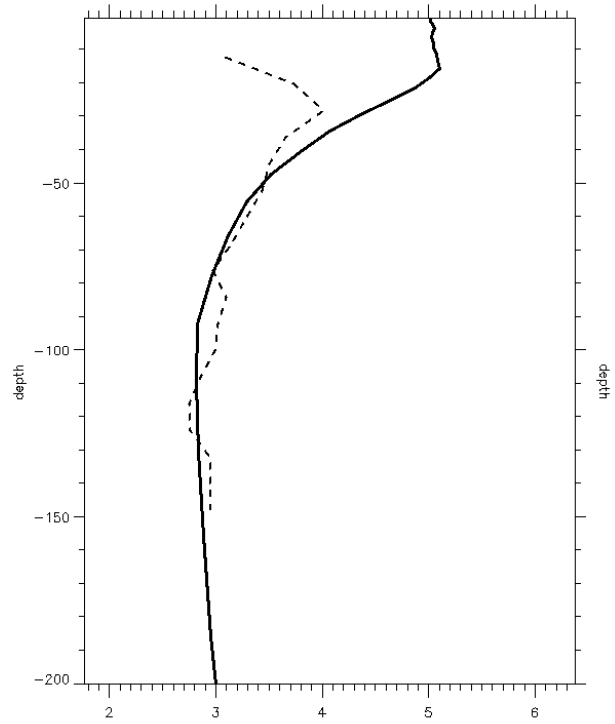
Figure 13: Vertical profiles of the M2 semi major axis (cm.s -1 ) as observed (dashed line) and Fig. 13. Vertical profiles of the M2 semi-major axis (cms − 1 ) as modelled (full line) at the Matxitxako buoy location. observed (dashed line) and modelled (full line) at the Matxitxako buoy